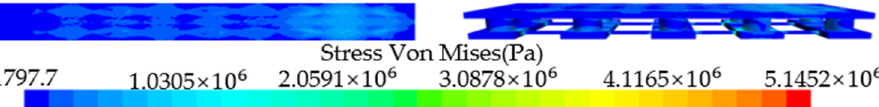
Figure 8. Stress under non-operational sea